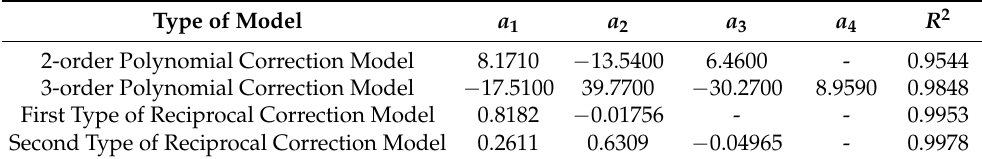
Table 3. The comparison of parameter values of coefficients of determination R 2 for four correction models.